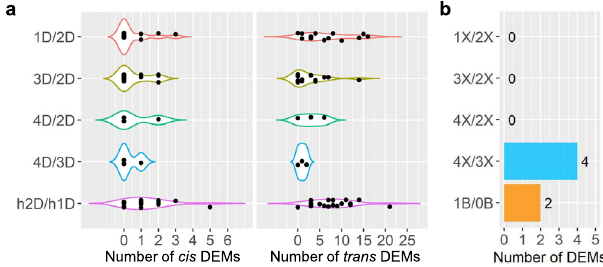
Fig. 6 The number of DEMs in each comparison. DEMs were computed by signi fi cance (FDR or adjusted P value < 0.05), as in each scatter plot in Figs. 2 – 5, 7. a Number of cis (left panel) and trans (right panel) DEMs in each distal aneuploid compared with the control. Each data point represents the number of DEMs (x-axis) in each comparison (y-axis) as shown in Supplementary Data 3. b Number of DEMs in the ploidy series and B chromosome series compared with the control. Source data are provided in Supplementary Data